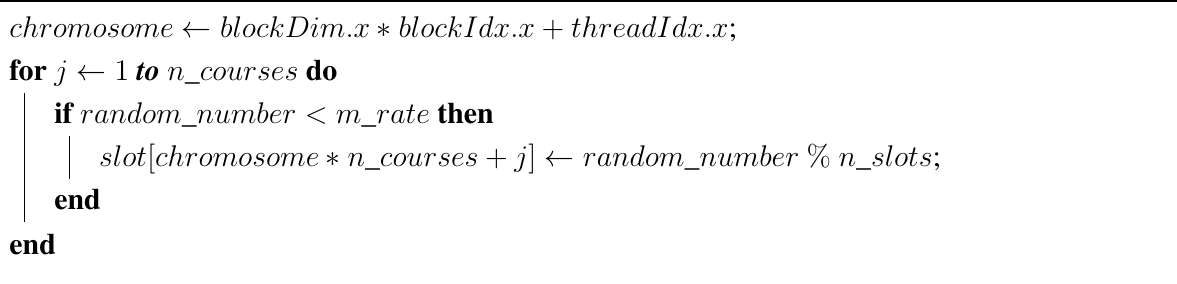
Algorithm 8: Mutation, chromosome-threaded approach: each thread mutates the genes in a single chromosome, according to a probability.